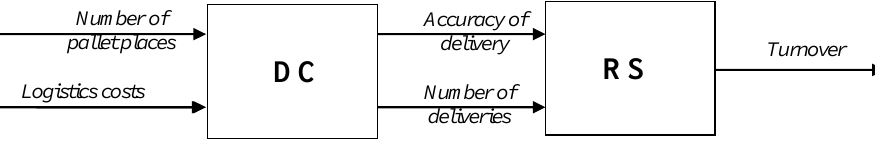
Figure 6. Two-component retail supply